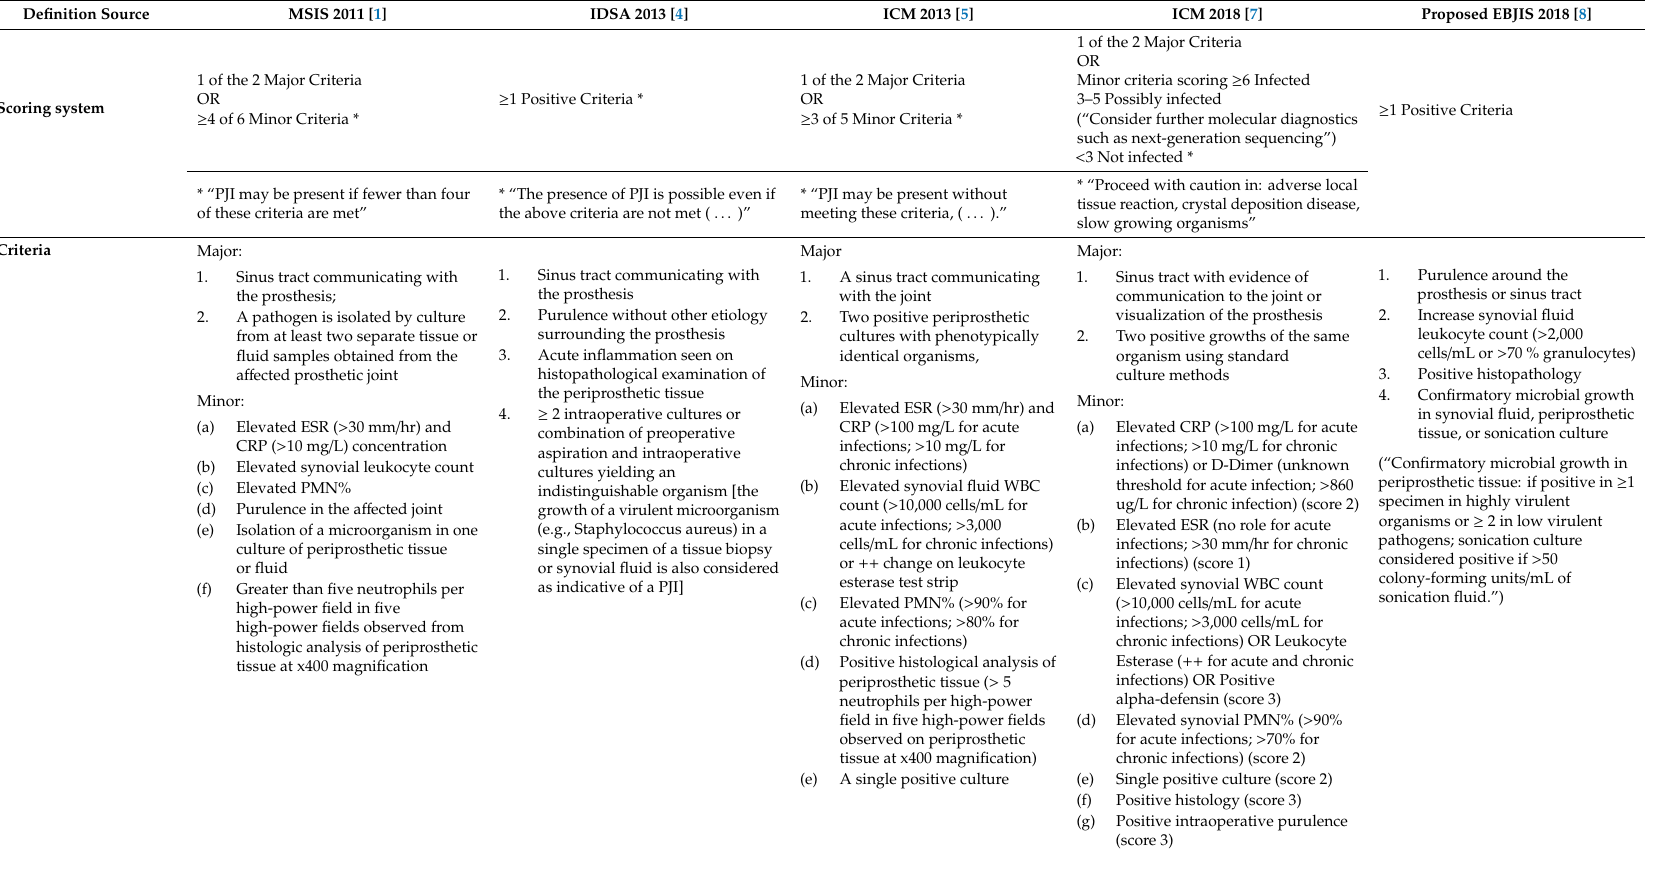
Table 1. Comparison of the diagnostic criteria, adopted in five peri-prosthetic joint infection (PJI) definitions, published from 2011 to 2018. Definition